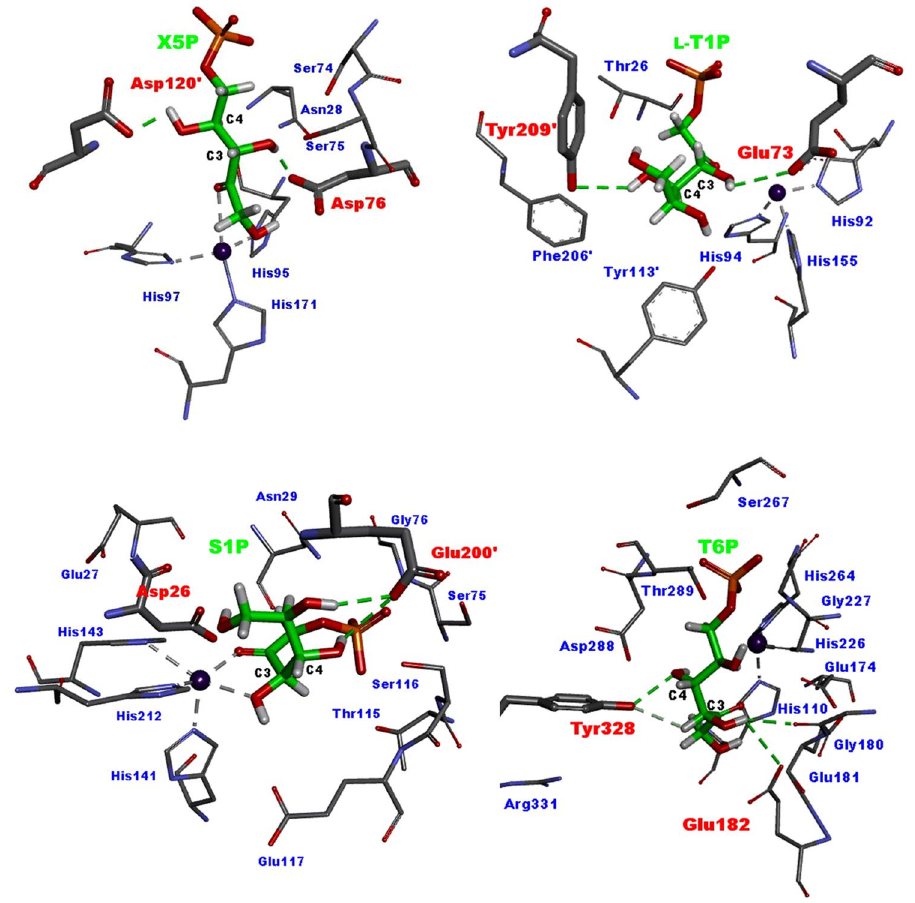
Figure 5. Docking models of AraD, FucA, RhaD, and FbaA for 4-epimerization. The models show the formation of hydrogen bonds at a catalytic acid and a base (bold) when docked with the dominant product of 4-epimerization. One residue forms a hydrogen bond with the C4-OH of the ligand while another forms a hydrogen bond with the C3-OH of the ligand (green), which is responsible for ligand deprotonation, respectively. ( A ) Docking of X5P in the active site of AraD formed by two adjacent subunits. Asp120 and Asp76 are a catalytic acid and a base for 4-epimerization of l-R5P to X5P, respectively. ( B ) Docking of l-T1P in the active site of FucA formed by two adjacent subunits. Tyr209 and Glu73 are a catalytic acid and a base residue for 4-epimerization of l-F1P to l-T1P. ( C ) Docking of S1P in the active site of RhaD formed by two adjacent subunits. Thr200’ and Asp26 are a catalytic acid and a base for 4-epimerization of P1P to S1P, respectively. ( D ) Docking of T6P in the active site of FbaA. Tyr328 and Glu182 are a catalytic acid and a base for 4-epimerization of F6P to T6P,